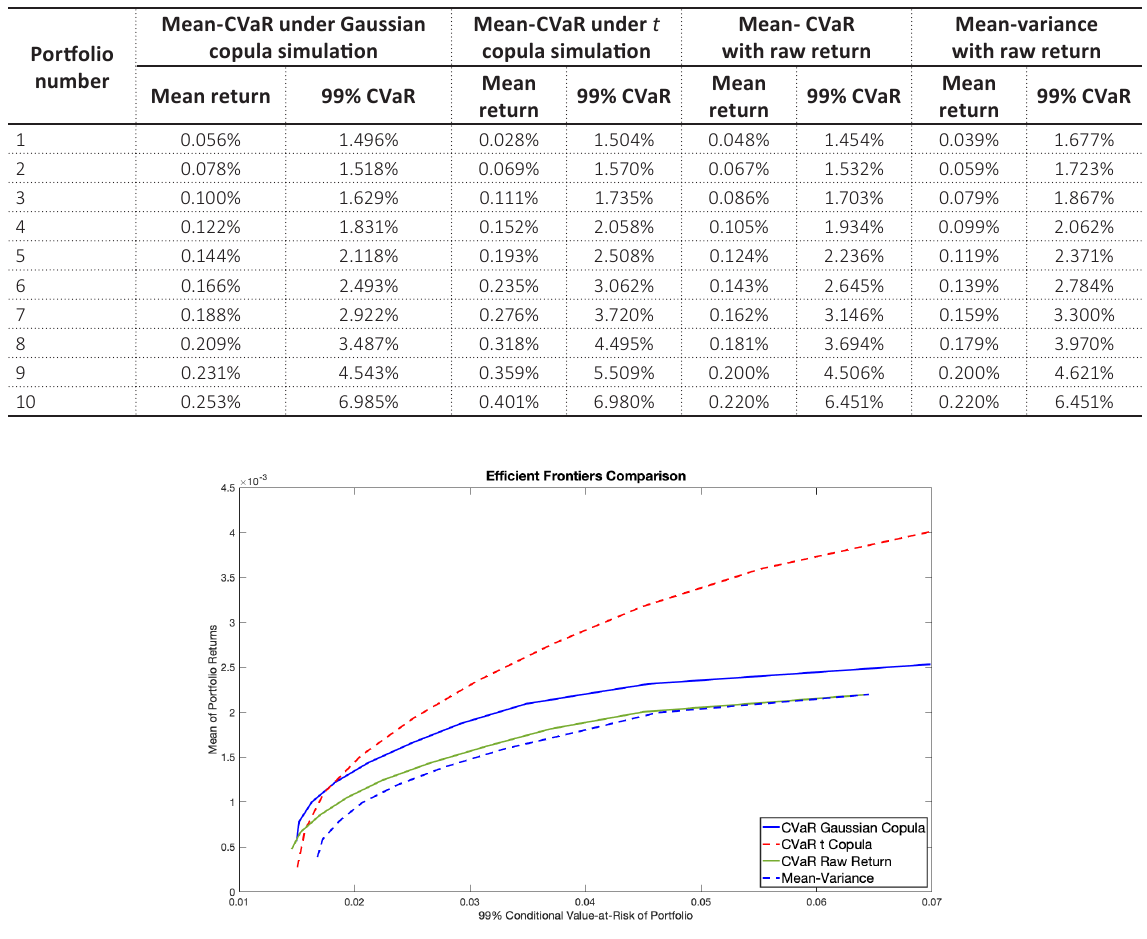
Table 5. Mean returns and 99% CVaR of 10 portfolios in each case (6.5-year duration)